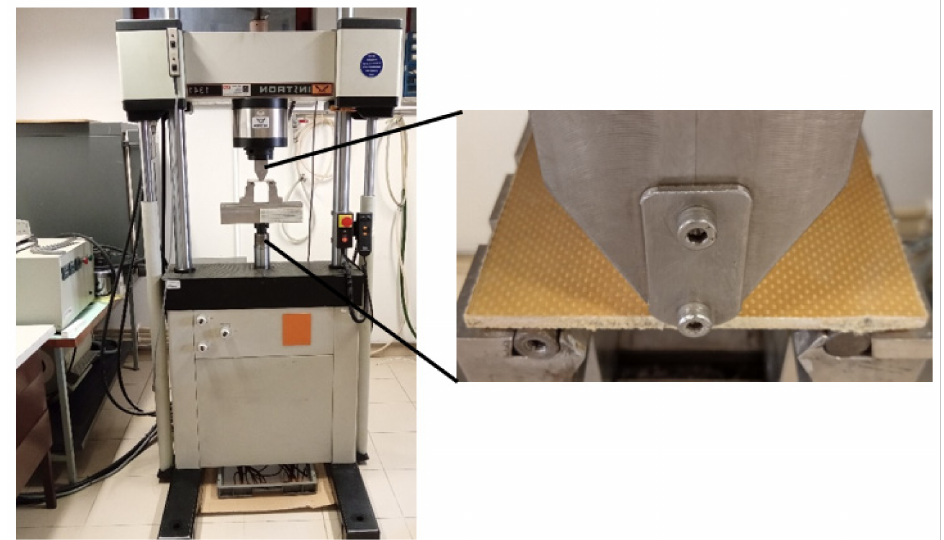
Figure 3. Details of the equipment used in fatigue testing.